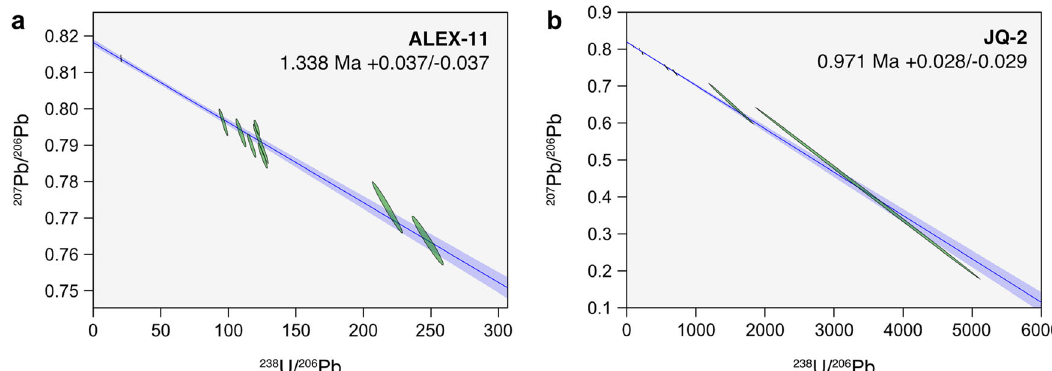
Fig. 3 Example U-Pb isochrons from two speleothem samples from the Naracoorte Cave Complex. a Stalagmite sample ALEX-11 from Alexandra cave. b Flowstone sample JQ-2 from James Quarry. See Supplementary Fig. 1 for all U-Pb